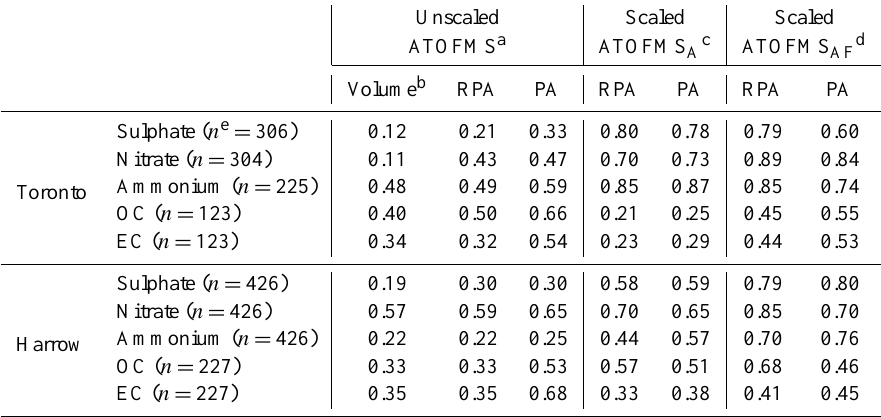
Table 2. Pearson correlation coefficients ( r ) between unscaled/scaled ATOFMS ion intensities and the hourly Sunset OCEC, GPIC (Toronto), and AMS (Harrow) measurements. Unscaled Scaled Scaled ATOFMS a ATOFMS Ac ATOFMS AFd Volume b RPA PA RPA Sulphate ( n e = Toronto